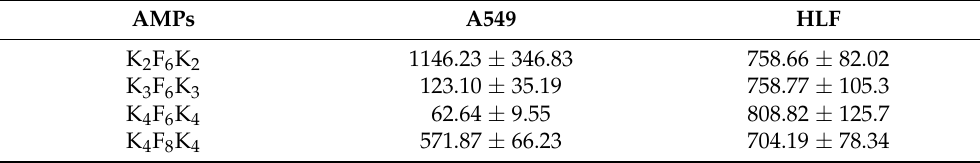
Table 2. Cytotoxicity (IC 50 , µ g/mL ± SD) of K n F m K n against A549 and HLF cells at 48